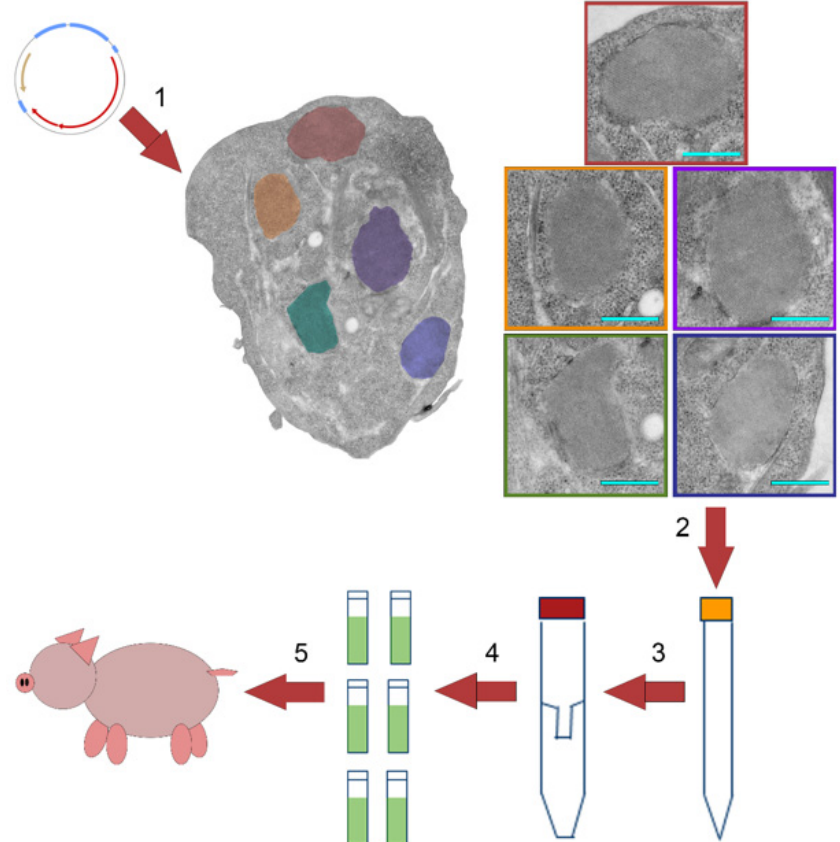
Figure 2. Virus-like particle (VLP) production process using transiently transfected mammalian cell cultures. (1) DNA plasmids encoding the FMDV P1 and 3C protease sequences were transfected into cell cultures using polyethylenimine. Transfected cells were incubated for 24 h to allow expression and processing of the P1 polypeptide resulting in the formation of cellular VLP arrays. Enlarge- ment of individual arrays are presented inside of color-coded boxes; blue bar represents 500 nm. (2) VLPs were harvested by lysis of cells using LB9 and (3) concentrated by a centrifugal concentrator column. (4) The retained high molecular weight fraction was aliquoted into doses and stored frozen until (5) administered to swine or cattle. Table 1. Vaccination parameters and clinical results for cattle and swine. Full protection from clini- cal FMD was achieved with a single mamVLP dose in cattle and two doses of mamVLPs in swine. Protection from fever is defined as rectal temperatures ≤ 39.6 °C, sampled daily, and protection from viremia is defined as negative RT-PCR (Ct <40) at sampled time points (3, 7, or 8, and 14 days post- challenge for swine and 7, 14, and 21 days post-challenge for cattle). The geometric mean virus neu- tralization antibody titers (VNTs) with standard deviation (SD) on the day of challenge (doc) are included. Control animals were not sampled for viremia as all animals displayed clinical disease. * Two swine demonstrated clinical FMD lesions before demonstrating fever and were euthanized. Protection From Species